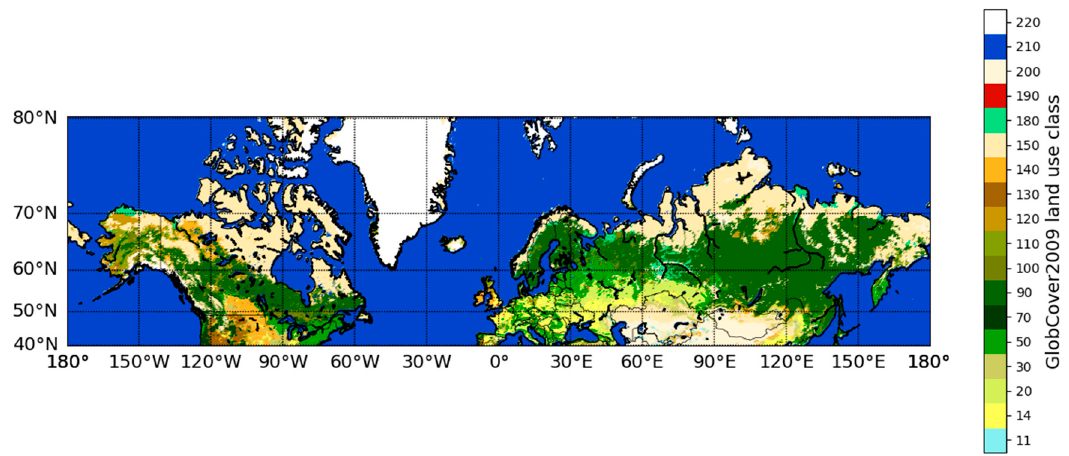
Figure 1. GlobCover2009 land-use classes coarsened to melt season data resolution. Table 1. GlobCover2009 classes found to be most common within one surface albedo (SAL) resolution unit in the study area and the number of occurrences of each class as the most common land-use class in one resolution unit of melt season data.